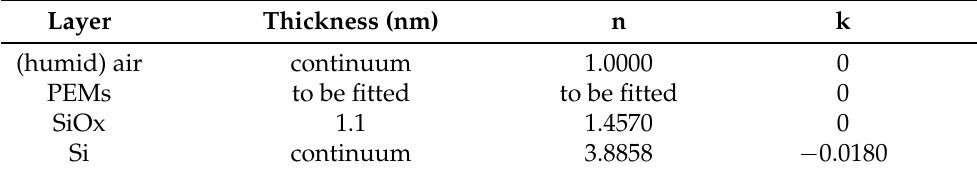
Table 1. Summary of the parameters for the two-layer model required for the analysis of the ellipsometric data. PEMs: polyelectrolyte